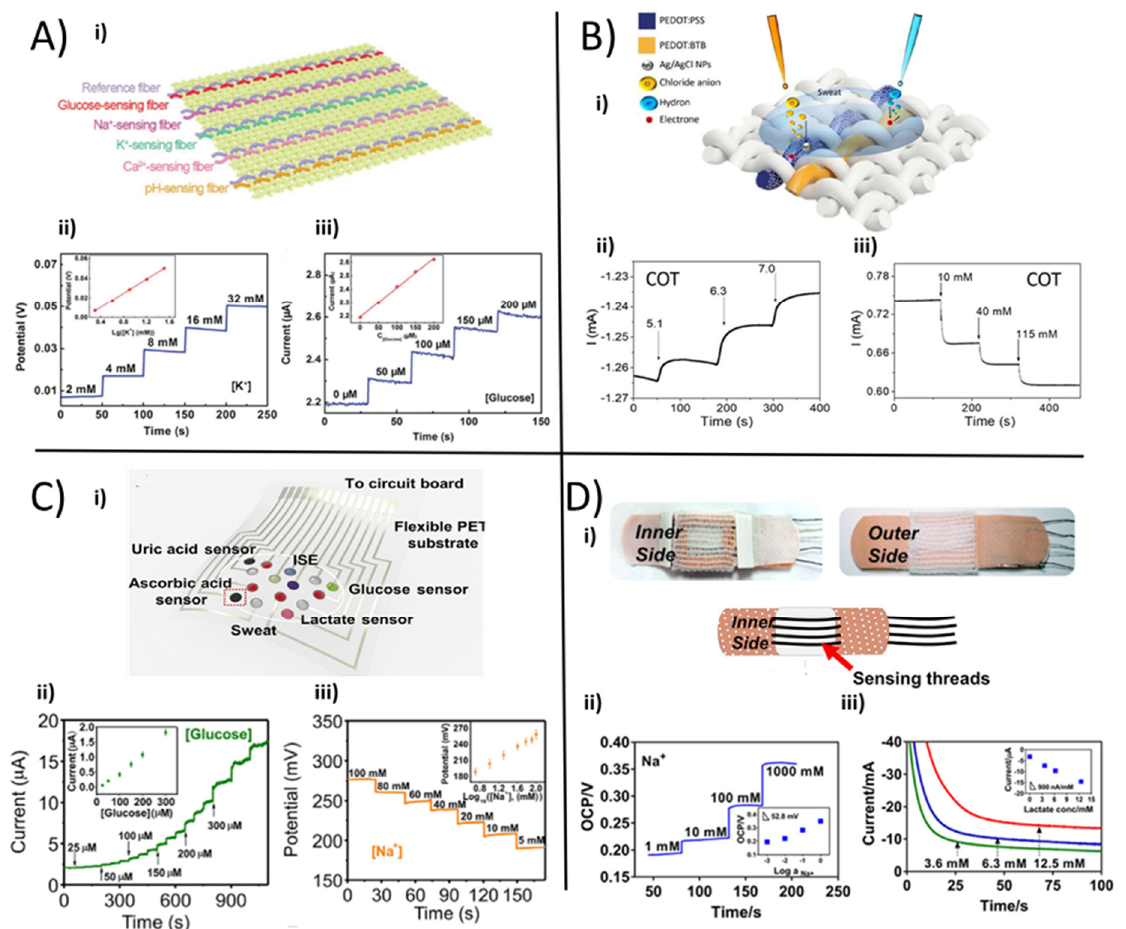
Figure 7. ( A ) i. Schematic illustration for the fabrication of the electrochemical fabric by weaving sensing fibers; ii. the open-circuit-potential (OCP) responses of the K + sensor to analyte additions, iii. the chronoamperometric response of the glucose-sensing fiber in PBS (reproduced from [36], Copyright (2021) Wiley). ( B ) i. Illustration of the textile multi-thread sensor platform. Current vs. time plot for cotton-based (ii) chloride and (iii) pH sensor in universal buffer solution [83]. ( C ) i. Photograph of the wearable sweat analysis patch; (ii) chronoamperometry response of silkNCT-based glucose sensor; (iii) OCP response of sodium sensor. The inset graphs are the calibration plots of the sensors [120]. ( D ) i. Photograph of the patch sensor prototype; ii. potentiometric response to sodium additions and iii. Chronoamperometric signal of lactate using filter paper soaked in proper analyte solutions [121].